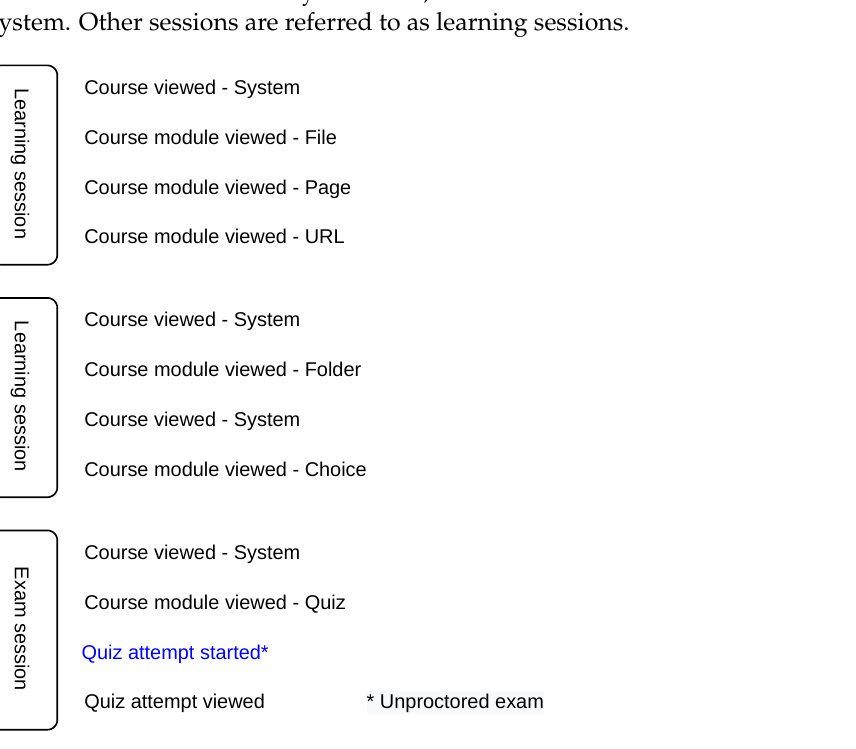
Figure 4. Learning and exam sessions. Exam sessions contain a general action for the exam